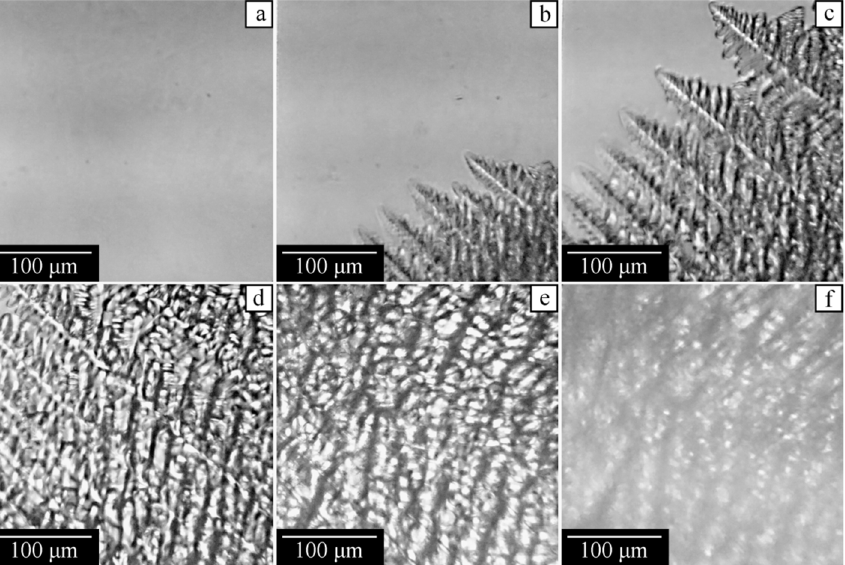
Figure 10. Optical micrographs of the PVDF–camphor mixture with 35 wt% of PVDF taken on cooling from the homogeneous state at ( a ) 180, ( b ) 160, ( c ) 155, ( d ) 150, ( e ) 108, and ( f ) 75 °C.